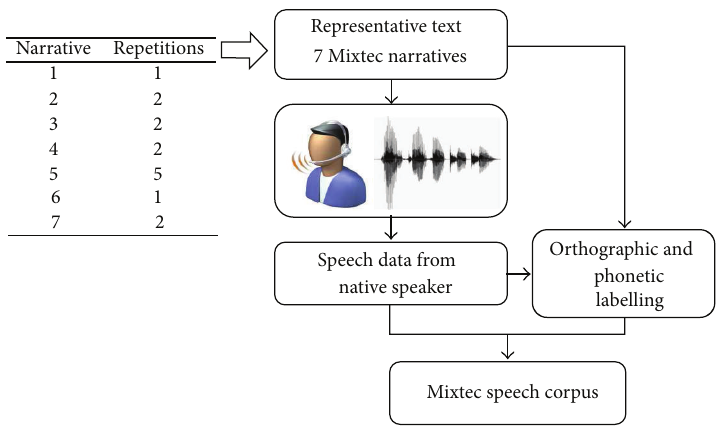
Figure 3: Steps to obtain the Mixtec speech corpus.